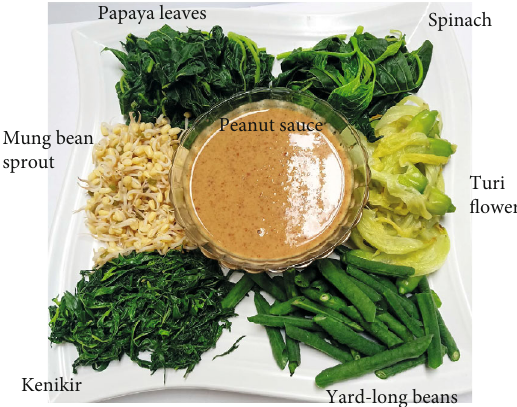
Figure 3: The cooked Pecel vegetables and peanut sauce are ready to be consumed by mixing/dressing the vegetables with the peanut sauce. In this study, the cooked vegetables and peanut sauce were homogenised using a kitchen blender for